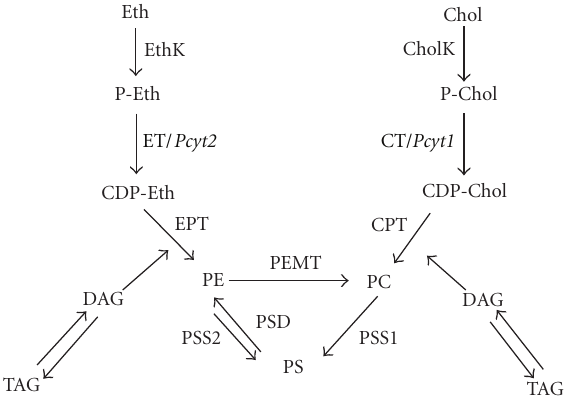
Figure 7: Phospholipid biosynthetic pathways. PE is made by the CDP-ethanolamine pathway in the ER (left) or from PS via the action of PSD in mitochondria. PC is made by the CDP- choline pathway (right) or from PE through the PEMT pathway in the ER and mitochondria-associated membranes of the ER. PS is produced from PE and PC via PSS2 and PSS1 pathways in the mito- chondria associated membranes of the ER. Ethanolamine kinase: EthK; CTP: ethanolaminephosphate; cytidylyltransferase: ET; CDP: diacylglycerol ethanolamine and choline phosphotransferases: EPT and CPT; choline kinase: CK; CTP: cholinephosphate cytidylyl- transferase: CT; CDP: diacylglycerol choline and ethanolamine phosphotransferases: CPT and EPT; Phosphatidylethanolamine N- methyltransferase: PEMT; phosphatidylserine synthase 1: PSS1; phosphatidylserine synthase 2: